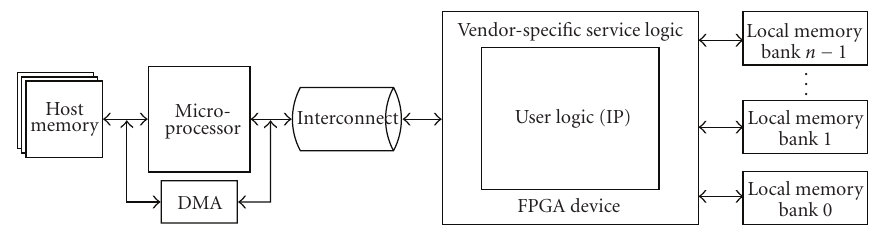
Figure 1: General architecture of a reconfigurable